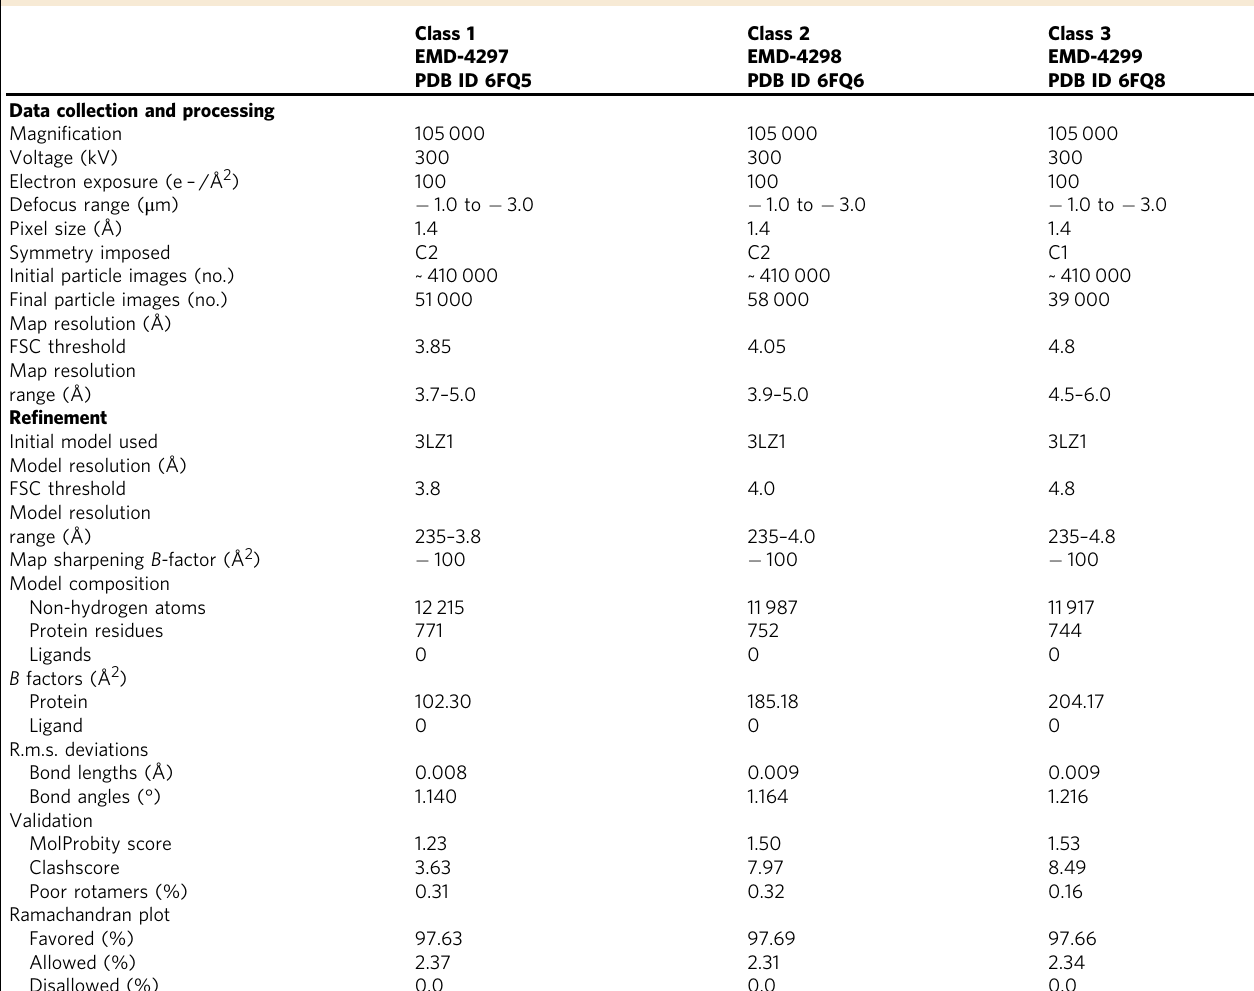
Table 1 Cryo-EM data collection, re fi nement, and validation